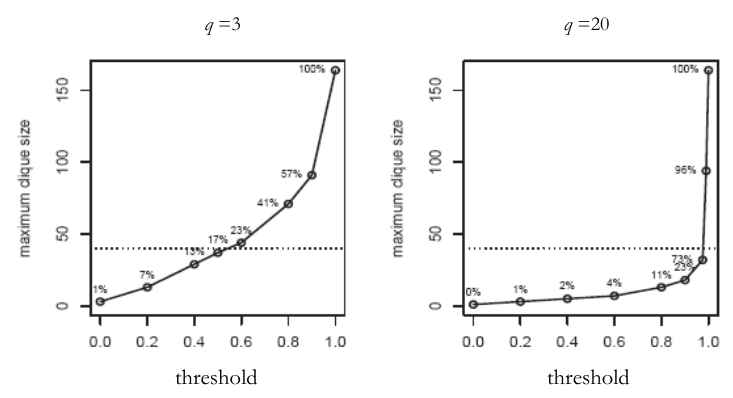
Figure 4 – Plots giving the largest clique sizes of the graphs selected with different threshold values. For every graph the percentage edges is given and the dotted horizontal line is the sample size n